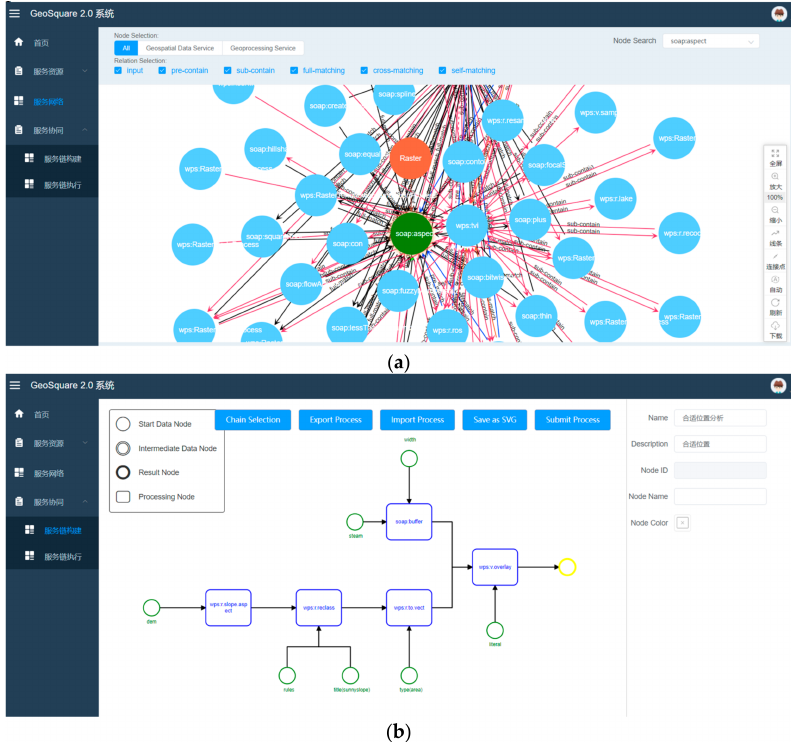
Figure 6. ( a ) Geospatial service web; ( b ) service chain